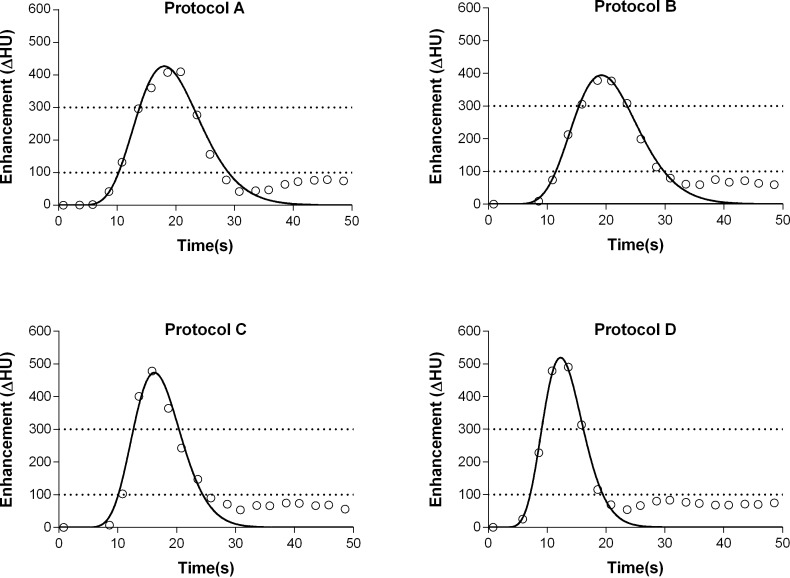
Fitted time attenuation curves of the aorta from a representative animal for protocols A, B, C and D. The dotted line at 100 HU represents the bolus tracking threshold level; the dotted line at 300 HU represents the diagnostic target attenuation. The diagnostic window (enhancement > 300 HU) is comparable for all protocols (7–9 s), and the bolus tracking delay time is shorter for protocols C and D than that for protocols A and B.